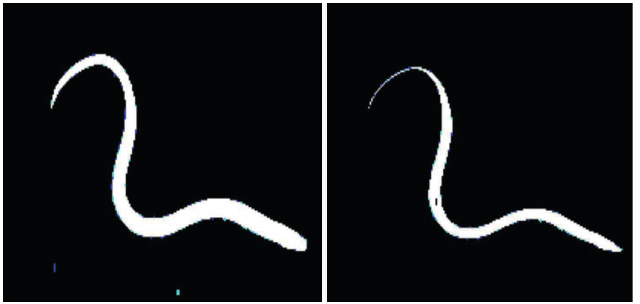
Fig. 7. An illustration of using erosion operation on the original image (left) and producing an image on the right. 5)